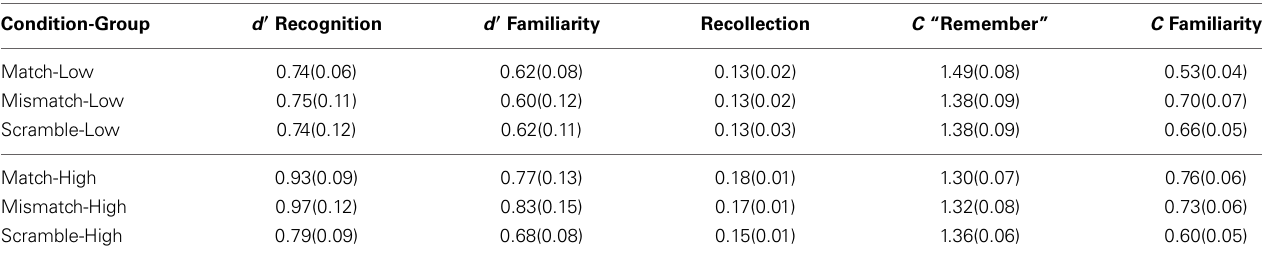
Table 1 | Recognition accuracy, familiarity, recollection, and criterion placement for participants with high or low level of prime awareness.